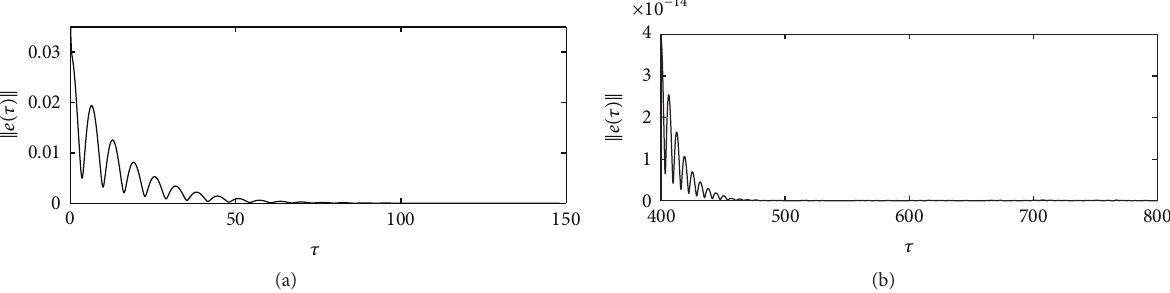
Figure 5: Time evolution of the synchronization errors norm with the propose scheme (7).